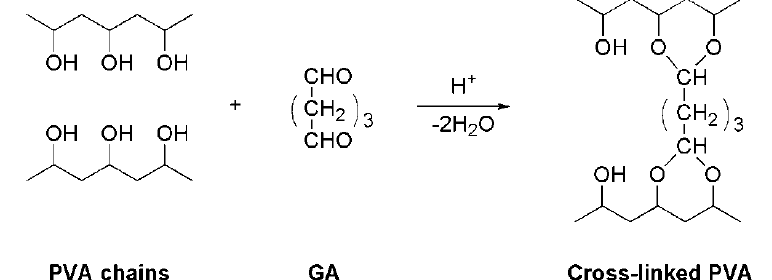
Figure 9. Scheme of chemical cross-linking of poly(vinyl alcohol) (PVA) using glutaraldehyde